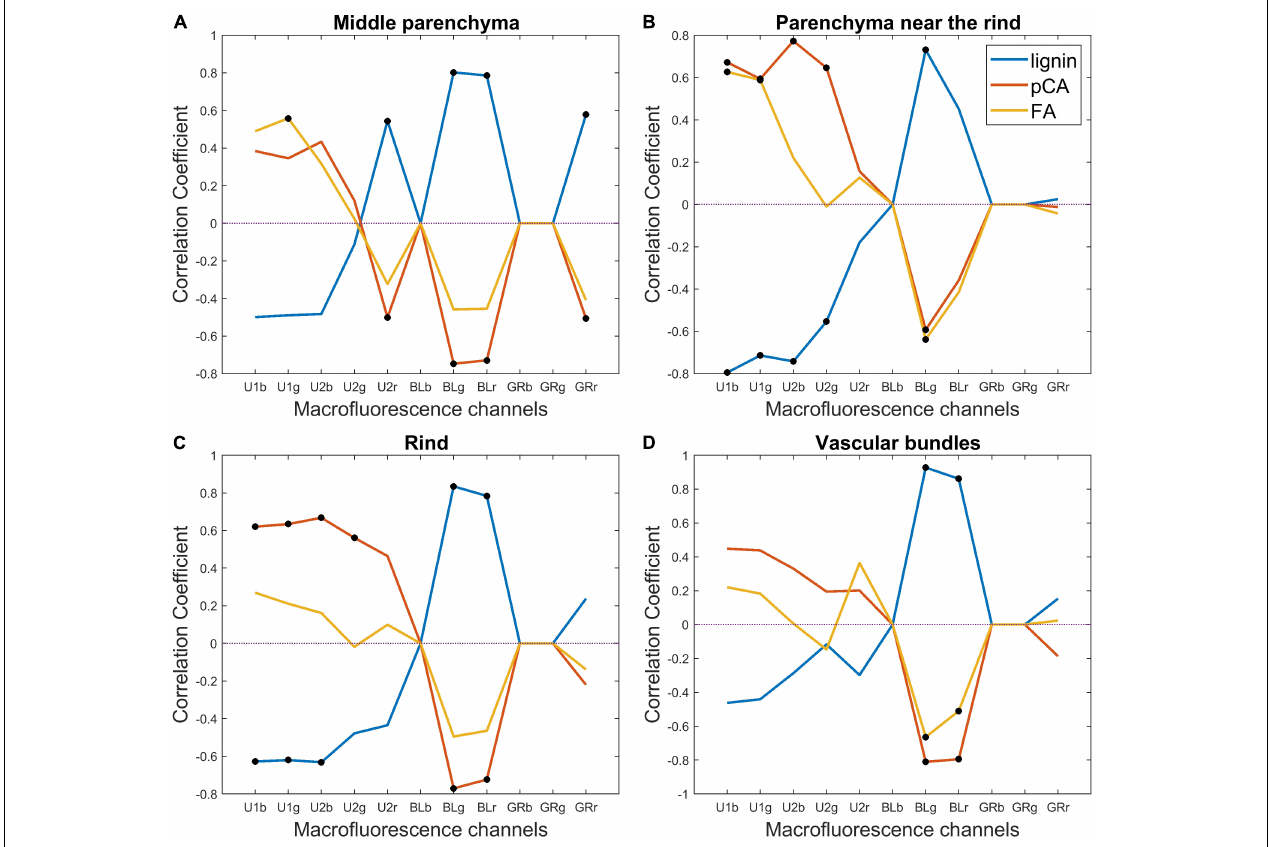
FIGURE 11 | Macrofluorescence analysis. Correlation among lignin, para-coumaric acid (pCA), ferulic acid (FA) and tissue autofluorescence pseudospectra: (A) middle parenchyma, (B) parenchyma near the rind, (C) rind, and (D) vascular bundles. Significant coefficients are highlighted by black points. For all tissues, a significant positive correlation was found between lignin and blue-induced fluorescence. For para-coumaric acid, significant positive correlations were found for UV-induced fluorescence in the rind and in the parenchyma near the rind but not in vascular bundles and middle parenchyma.